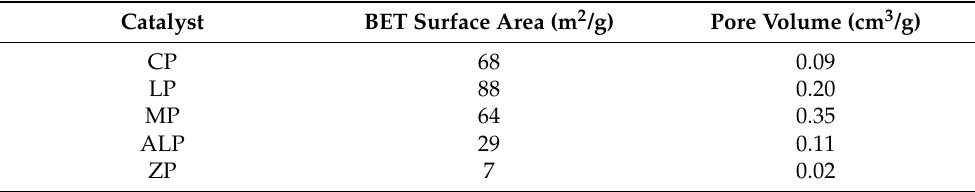
Table 1. Textural properties of different metal phosphate catalysts.